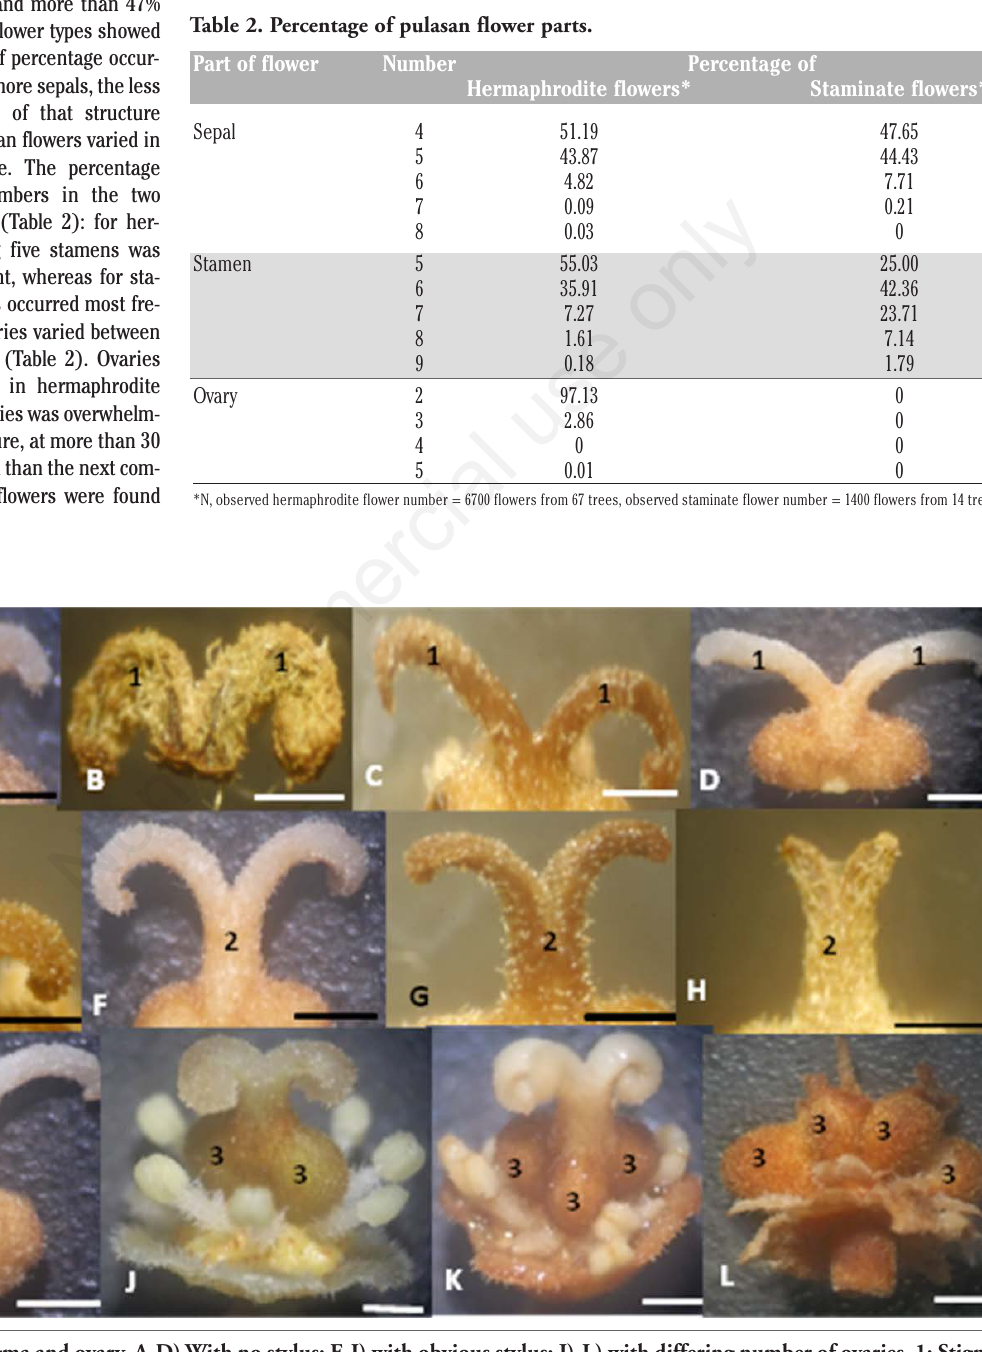
Figure 4. Variation of stigma and ovary. A-D) With no stylus; E-I) with obvious stylus; J)-L) with differing number of ovaries. 1: Stigma, 2: stylus, 3: ovary. Scale bar = 1 mm.